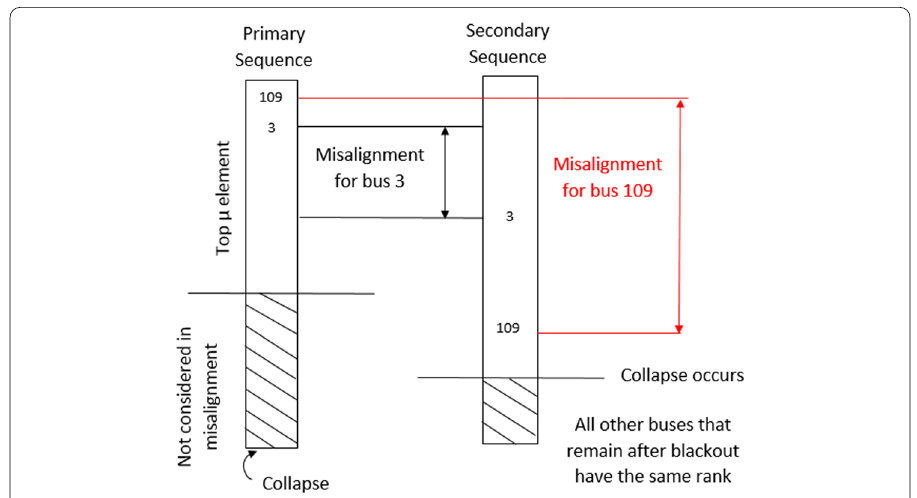
Fig. 9 Explanation of the ASM application between two fault sequences